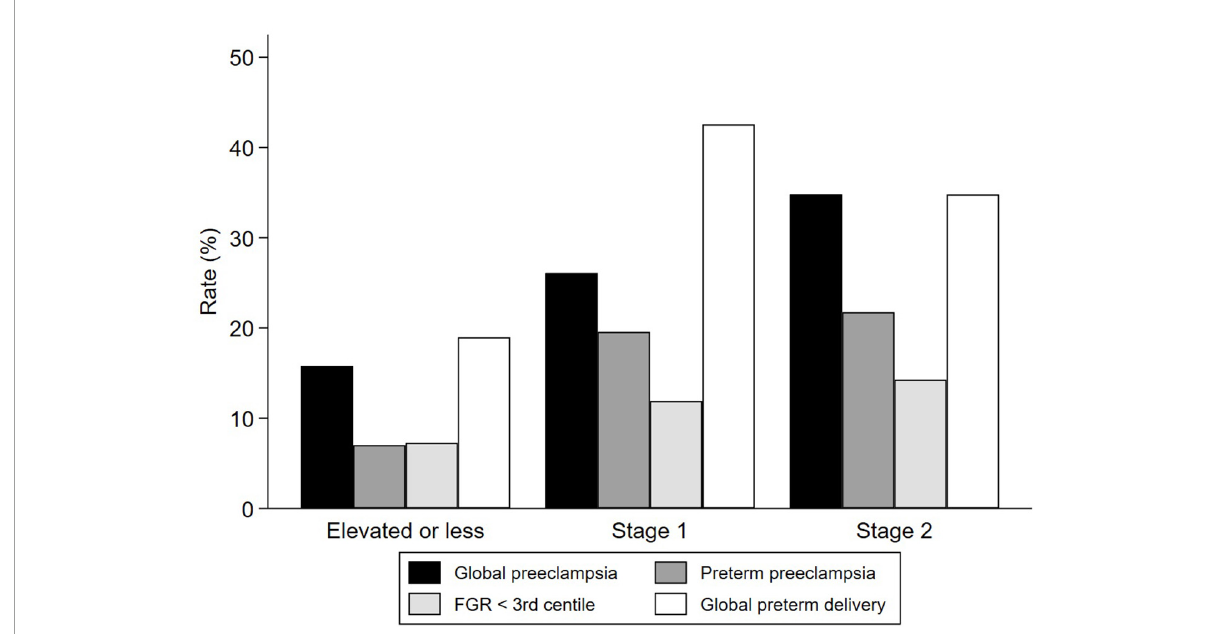
FIGURE2 Perinatal outcomes of placental-mediated diseases according to blood pressure stage at the first-trimester scan. FGR, fetal growth restriction.